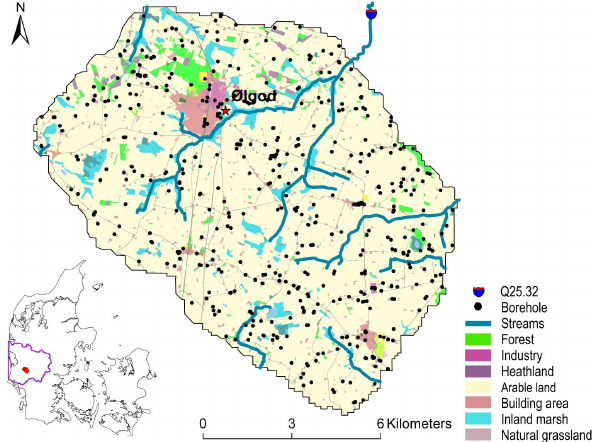
Figure 1: Location and land use of the study area. Black points denote the 525 boreholes whose 2 Figure 1. Location and land use of the study area. Black points logs were used as hard data in the geostatistical simulations. 3 denote the 525 boreholes whose logs were used as hard data in the geostatistical